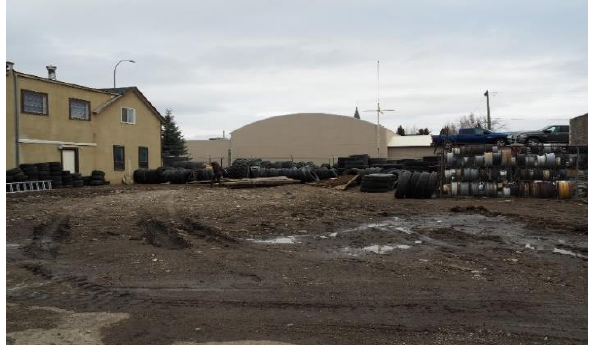
Figure 10: The Quon Sang Lung Laundry building site following demolition of the structure. Source: Peter